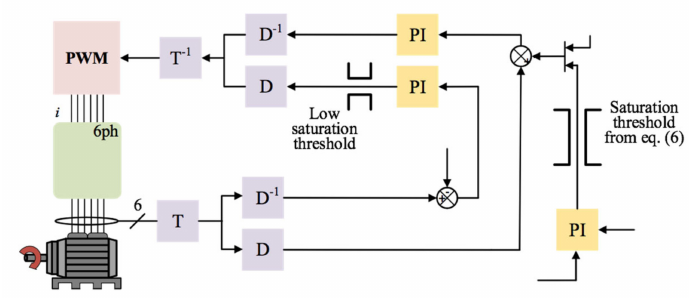
Figure 2. Proposed automatic fault-tolerant control (AFTC)